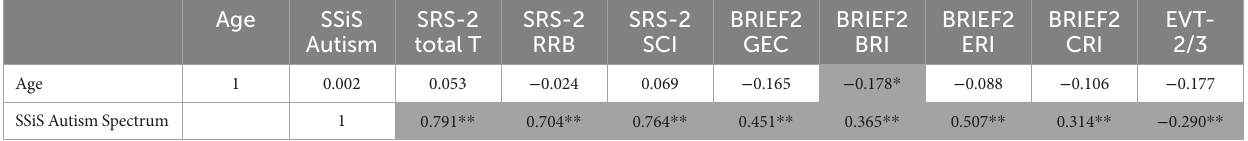
TABLE 6 Pearson’s r correlation coefficients for SSiS autism spectrum subscale raw scores and other study measures.